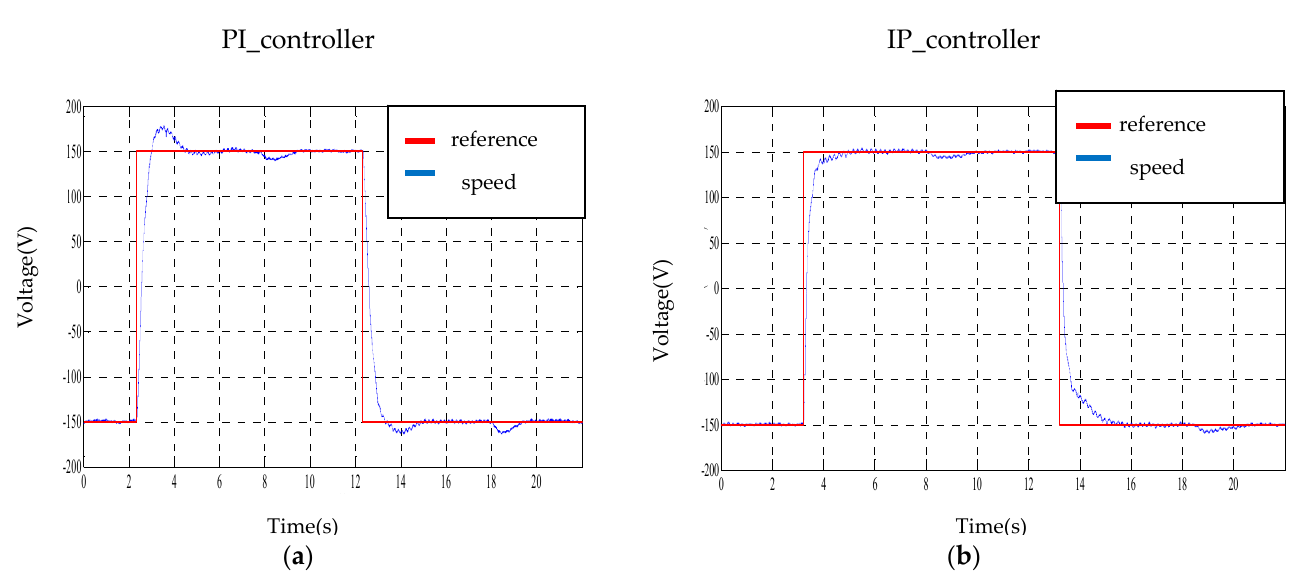
Figure 18. Comparison between 3L_FOC in closed loop conditions using PI and IP controller in term of: ( a , b ) Small speed response with injection of perturbation.